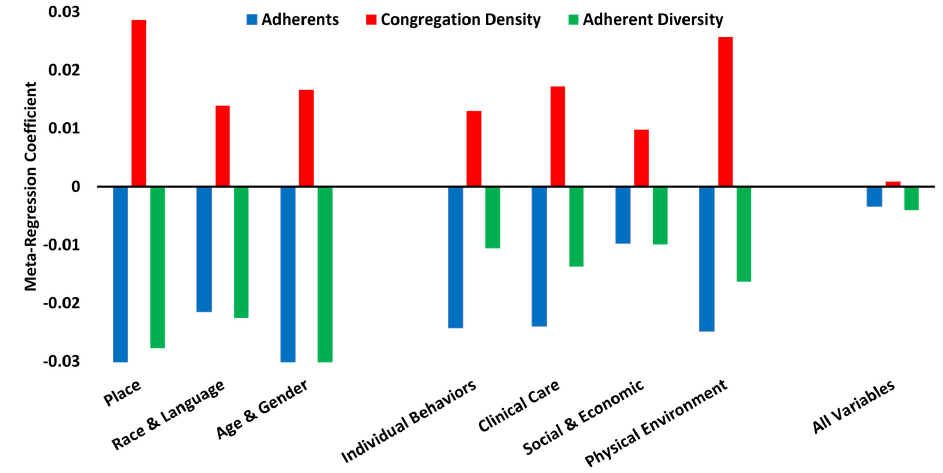
Figure 2. Consistency of Religion–Mortality Direction of Association.